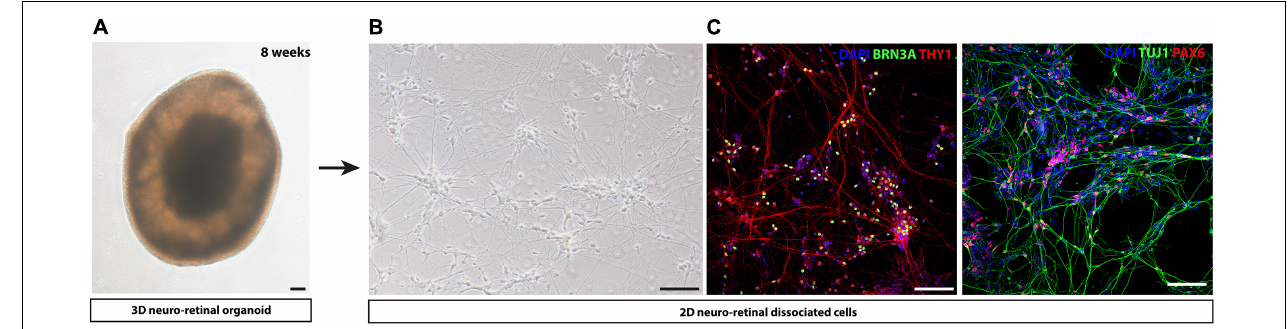
FIGURE 2 | Representative images of human iPS cell-derived RGCs by adapting protocol from Reichman et al. (2017). (A) Representative image of a self-organized 8-week-old 3D retinal organoid (B) Retinal cells dissociated from 8-week-old 3D retinal organoids observed using phase contrast microscopy. (C) Immunostaining on retinal cells dissociated from 8-week-old 3D retinal organoids reveal the expression of neuronal markers (THY1, TUJ1), retinal progenitor cell-associated marker (PAX6) and RGC-associated marker (BRN3A). Nuclei were counterstained by DAPI (blue). Scale bars: 100 µ